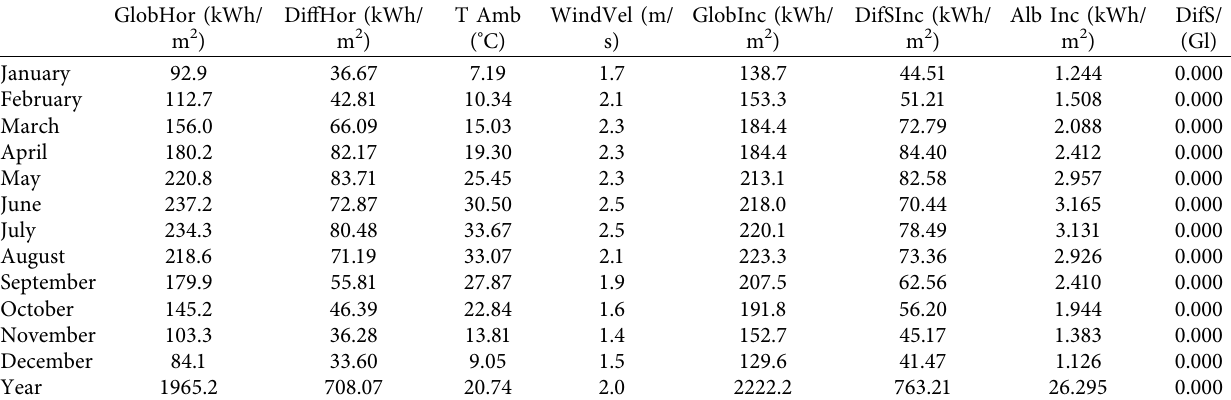
Table 2: Factors related to PV solar cells.